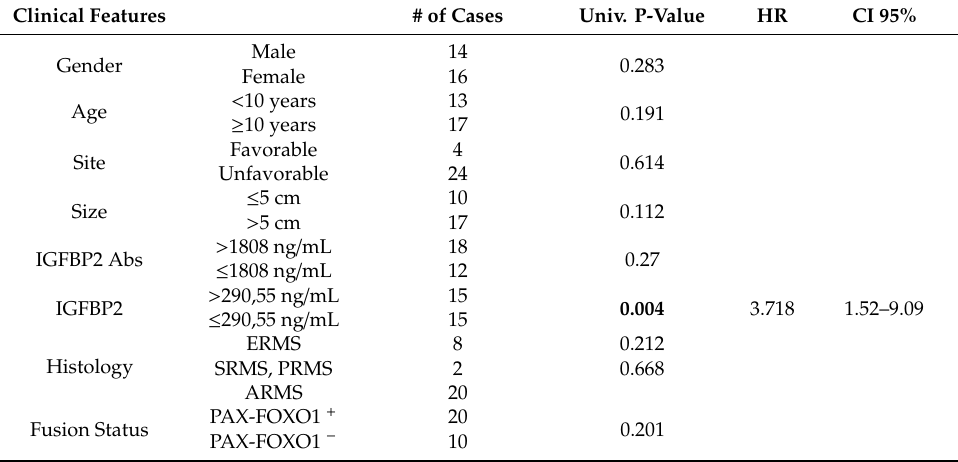
Figure 4. Overall survival (OS) analysis distinguishing metastatic RMS patients according to plasmatic IGFBP2 and anti-IGFBP2 autoantibodies levels. ( A ) IGFBP2 and ( B ) anti-IGFBP2 autoantibodies predictive values in metastatic RMS patients who died of disease or not. Kaplan-Meier survival analysis representing overall survival (OS) of metastatic RMS patients distinguished according to ( C ) IGFBP2 and ( D ) anti-IGFBP2 levels. Table 2. Univariate Cox regression analysis of event-free survival in 30 metastatic RMS patients. Clinical